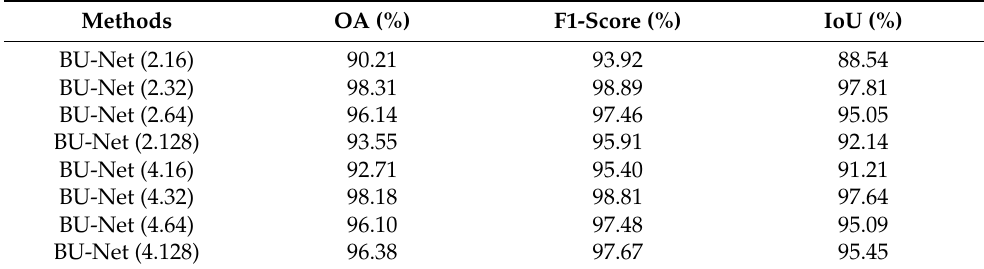
Table 3. Results of different